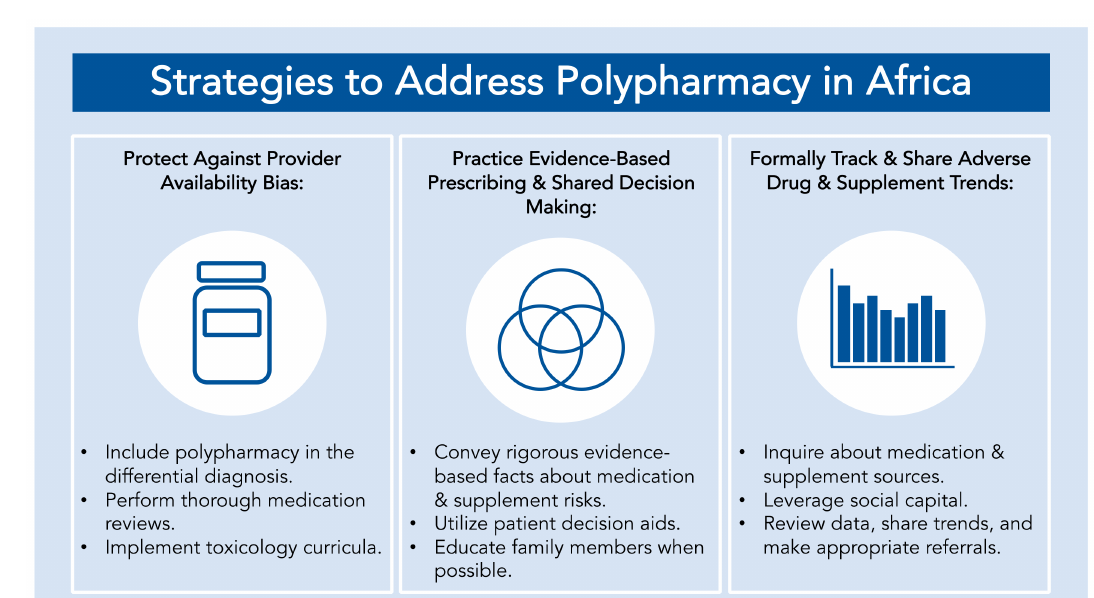
Figure 1. Immediately implementable strategies to address polypharmacy in Africa: by bolstering training to safeguard against provider availability biases, practicing evidence-based prescribing and shared decision making, and tracking and sharing local trends related to polypharmacy, healthcare providers and public health practitioners in Africa can better position themselves to meet the polypharmacy needs of their